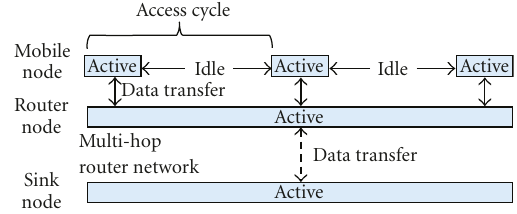
Figure 3: Node duty cycles and data transfer.